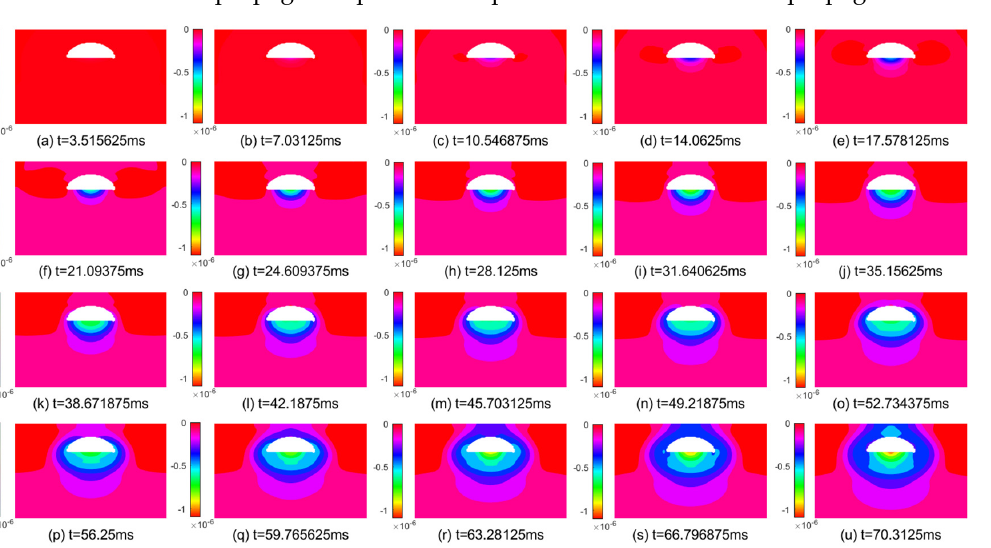
Figure 12. Distribution of u s with of domain ( x 1 , x 3 ) ∈ [ − 10, 10 ] × [ − 20, 0 ] at different times.